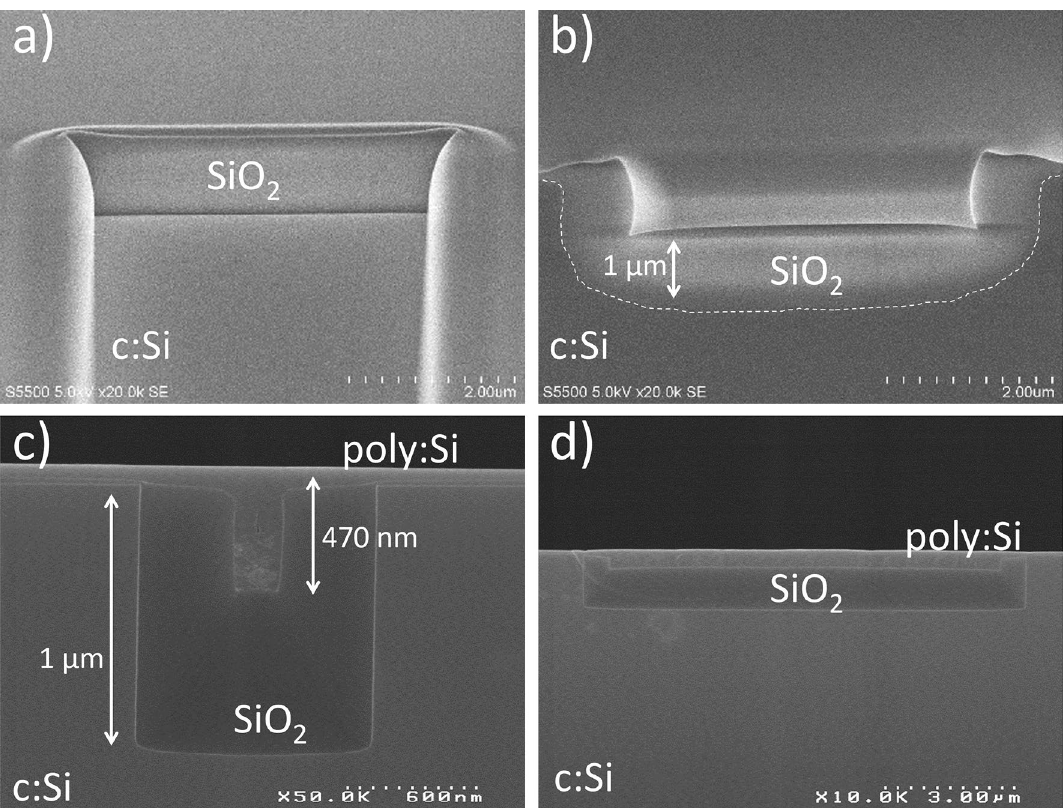
Figure 5. SEM images of: ( a ) deposited SiO2 in the bulk Si trenches (top view), ( b ) deposited SiO 2 (cross section), ( c ) deposited a:Si (side view) and ( d ) annealed a:Si into poly:Si (cross